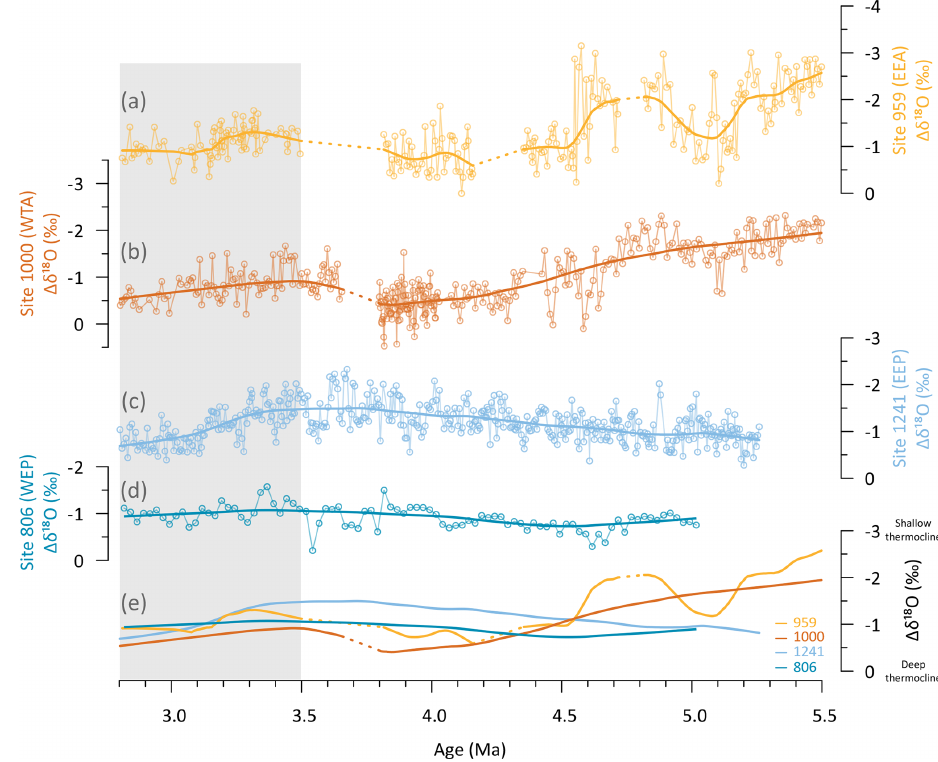
Figure 6. Compilation of tropical (cid:49)δ 18 O data. (a) Eastern Equatorial Atlantic (EEA) Site 959 (this study and Norris, 1998). (b) Western Tropical Atlantic (WTA) Site 1000 (Steph, 2005, and Steph et al., 2006a). (c) Eastern Equatorial Pacific (EEP) Site 1241 (Steph et al., 2006b). (d) Western Equatorial Pacific (WEP) Site 806 (LaRiviere et al., 2012). (e) LOESS smoothed records (span of 0.5 in PAST software; Hammer et al., 2001). Surface Trilobatus sacculifer records were corrected with + 0 . 33‰ to G. ruber based on their offset in the modern ocean (Steph et al., 2009). Blue square marks late Pliocene interval covered in Figs. 4 and